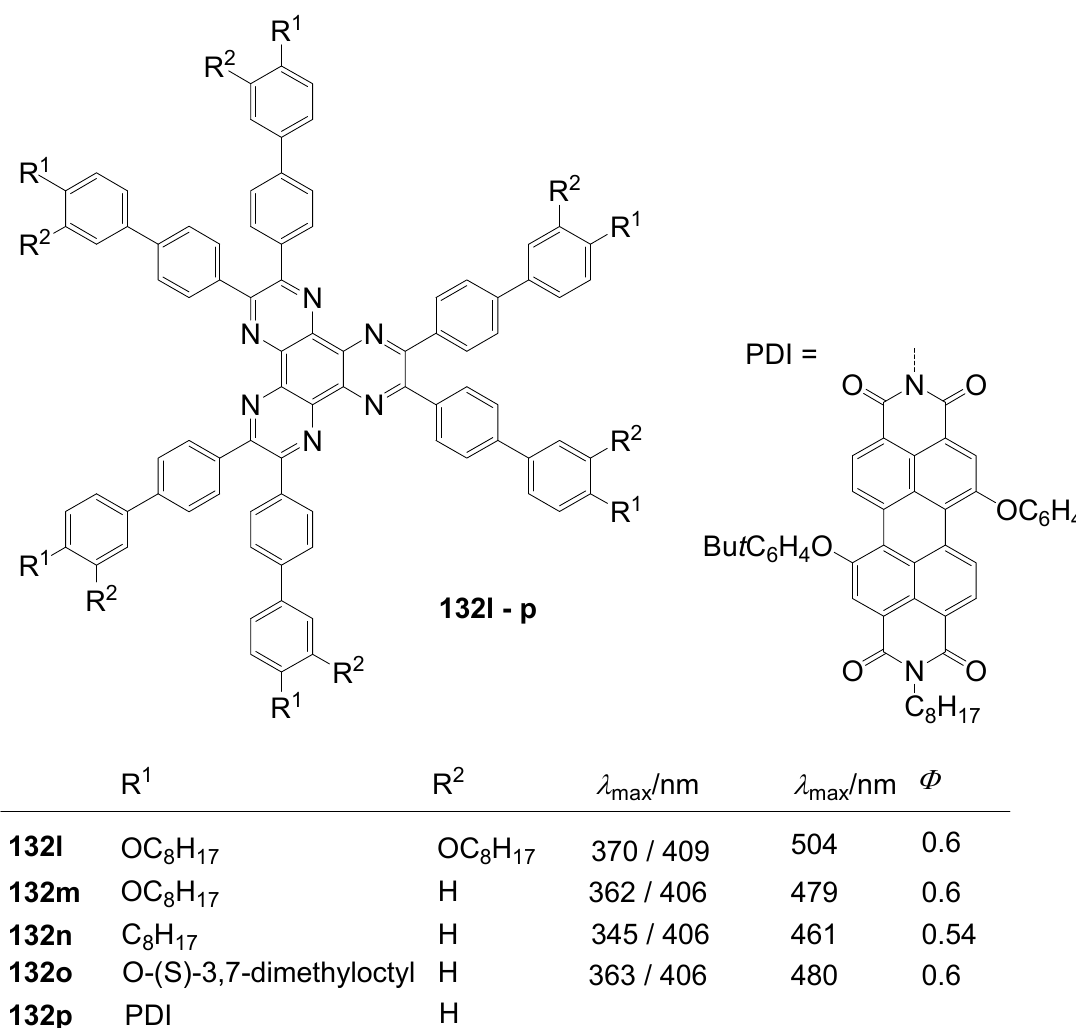
Figure 33. Hexakis(biphenylyl)-hexaazatriphenylenes 132l - p